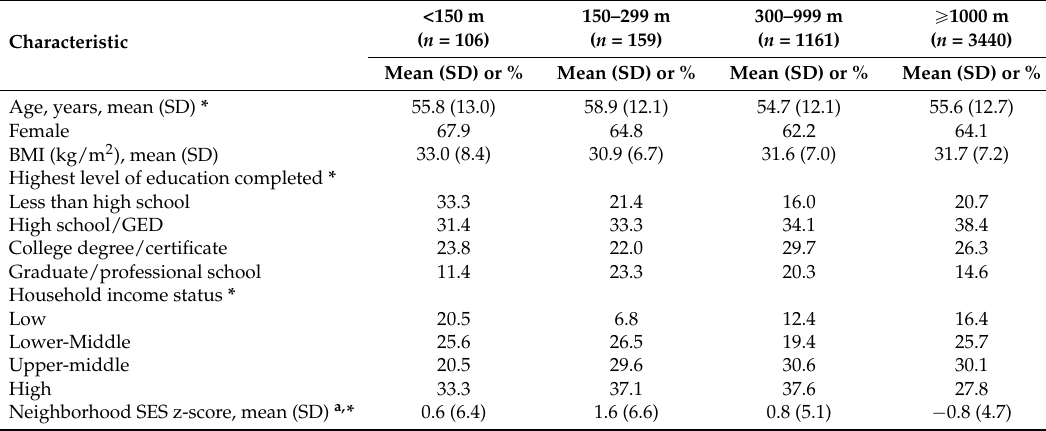
Table 1. Descriptive characteristics and markers of cardiac function among participants in the Jackson Heart Study by distance to A1 or A2 roads at baseline ( n =